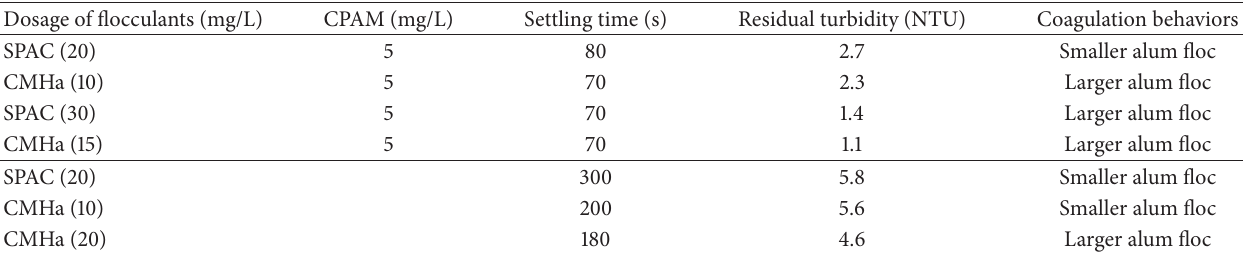
Table 12: Coagulation behaviors of CMHa versus PAC for domestic-sewage treatment (original wastewater 50 NTU). Dosage of flocculants (mg/L)